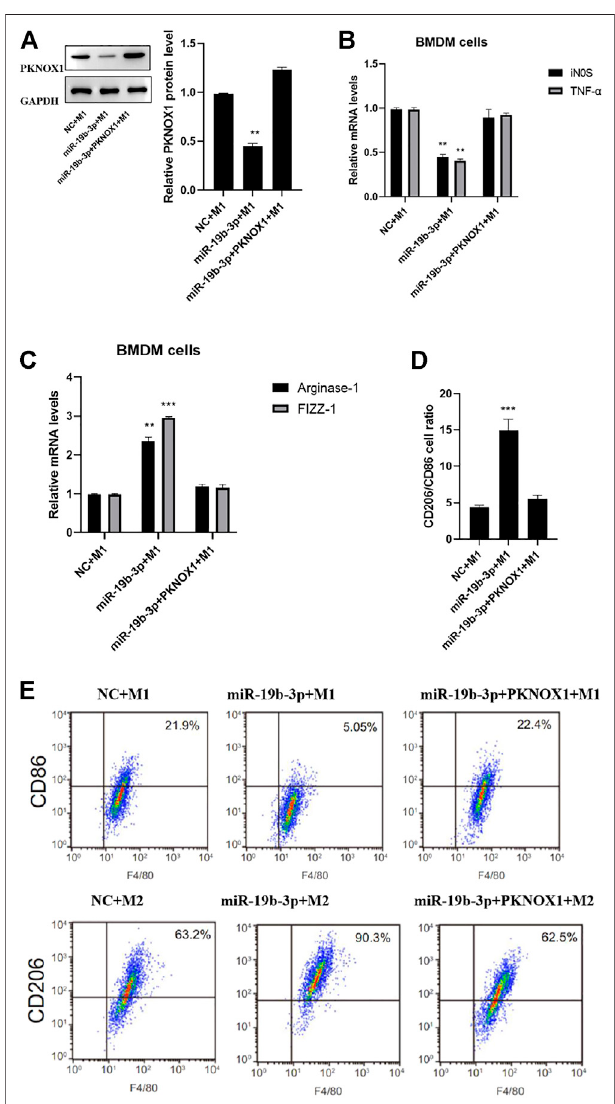
FIGURE 5 | Comparison of the polarization status of macrophages after different transfections. Western blot analysis of (A) PKNOX1, qRT-PCR detection (B) expression of inducible nitric oxide synthase and tumor necrosis factor- α after different transfections. (C) The expression of arginase-1 and FIZZ-1 mRNAwas detected byqRT-PCR. (D) Detection ofCD206/CD86 cell ratio by fl ow cytometry and (E) representative images of fl ow cytometry assays. p p < 0.05, pp p < 0.01, ppp p <